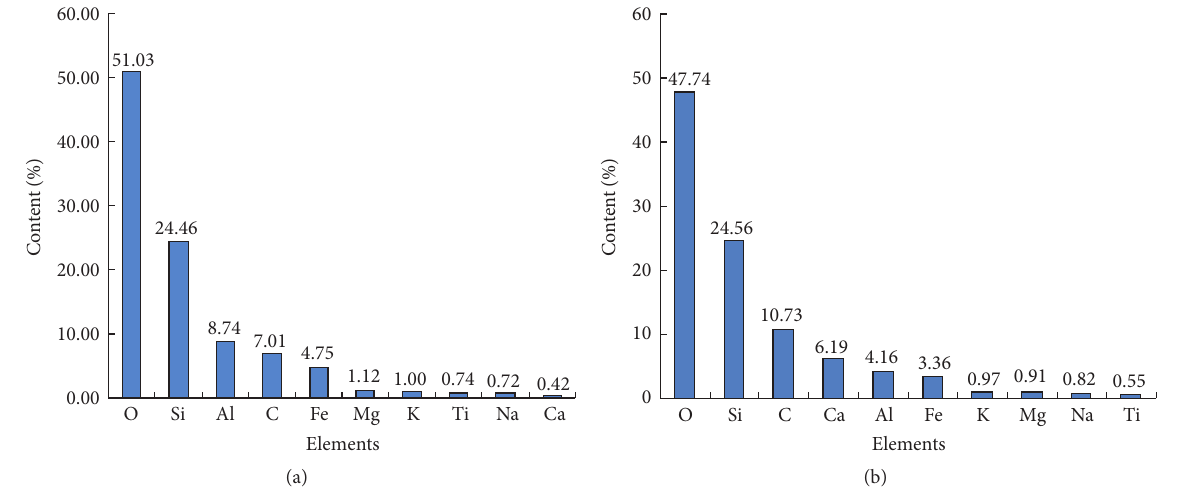
Figure 3: Elemental composition of the Zigong argillaceous siltstone with different weathered degrees: (a) highly weathered and (b) moderately